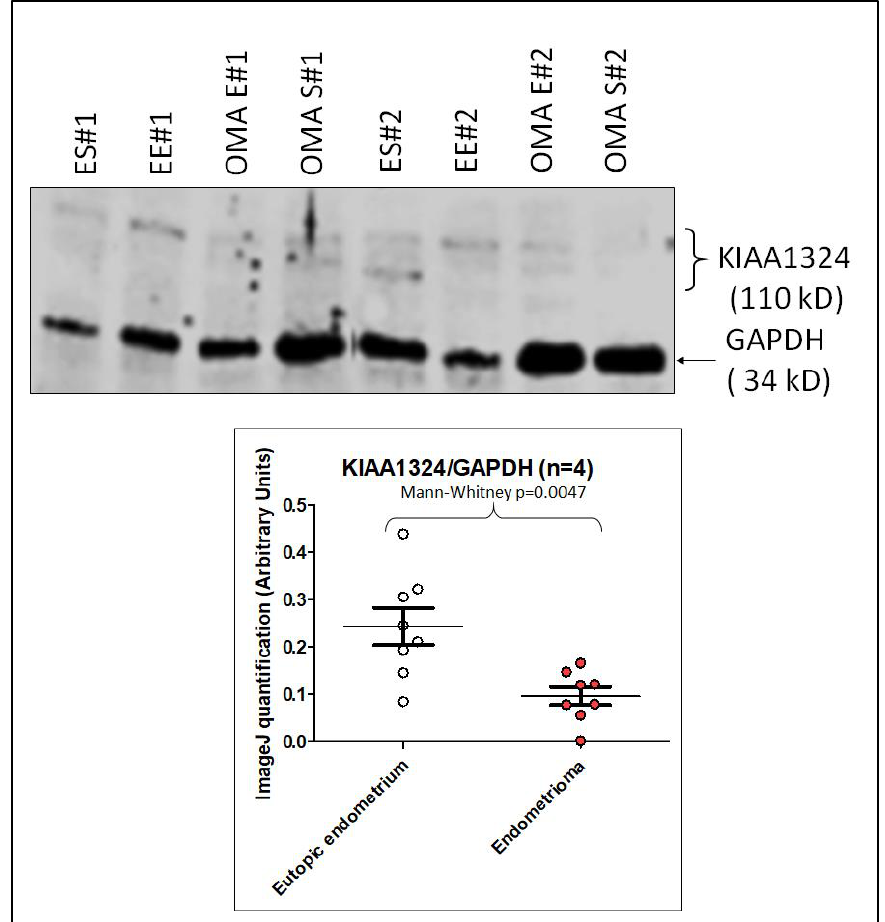
Figure 5. Western blot analysis with two representative patients (denoted as #1 and #2). The antibody against the COOH-terminal peptide of KIAA1324 was used at a concentration of 1:100. The lower part of the figure is a quantitative analysis of the WB using the 4 patients (only 2 are shown in the Western blot) after densitometry analysis by ImageJ. On the WB there are four lanes for each patient: eutopic epithelium, eutopic stroma, lesion epithelium and lesion stroma. Hence the 8 dots presented in the quantification. We never found any significant differences in behaviors of expression between the stromal and epithelial cells, and therefore we analyzed them together. Thus, the four patients led to 8 dots (4 + 4) for the eutopic endometrium and 8 dots for the ectopic endometrium (endometrioma lesion, 4 + 4). ES = Isolated Endometrial Stroma, EE = Isolated Endometrial Epithelium, OMA E = Isolated Endometrioma Epithelium, OMA S = Isolated Endometrioma Stroma.